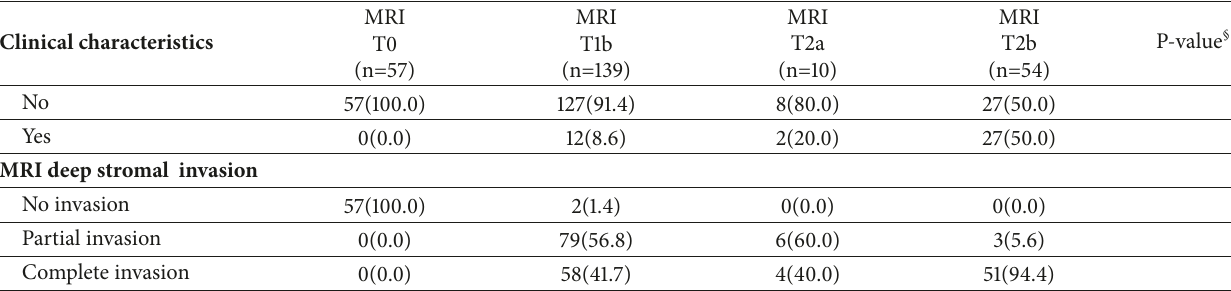
FIGO stages IA-IIA2 cervical cancer underwent radical hys-